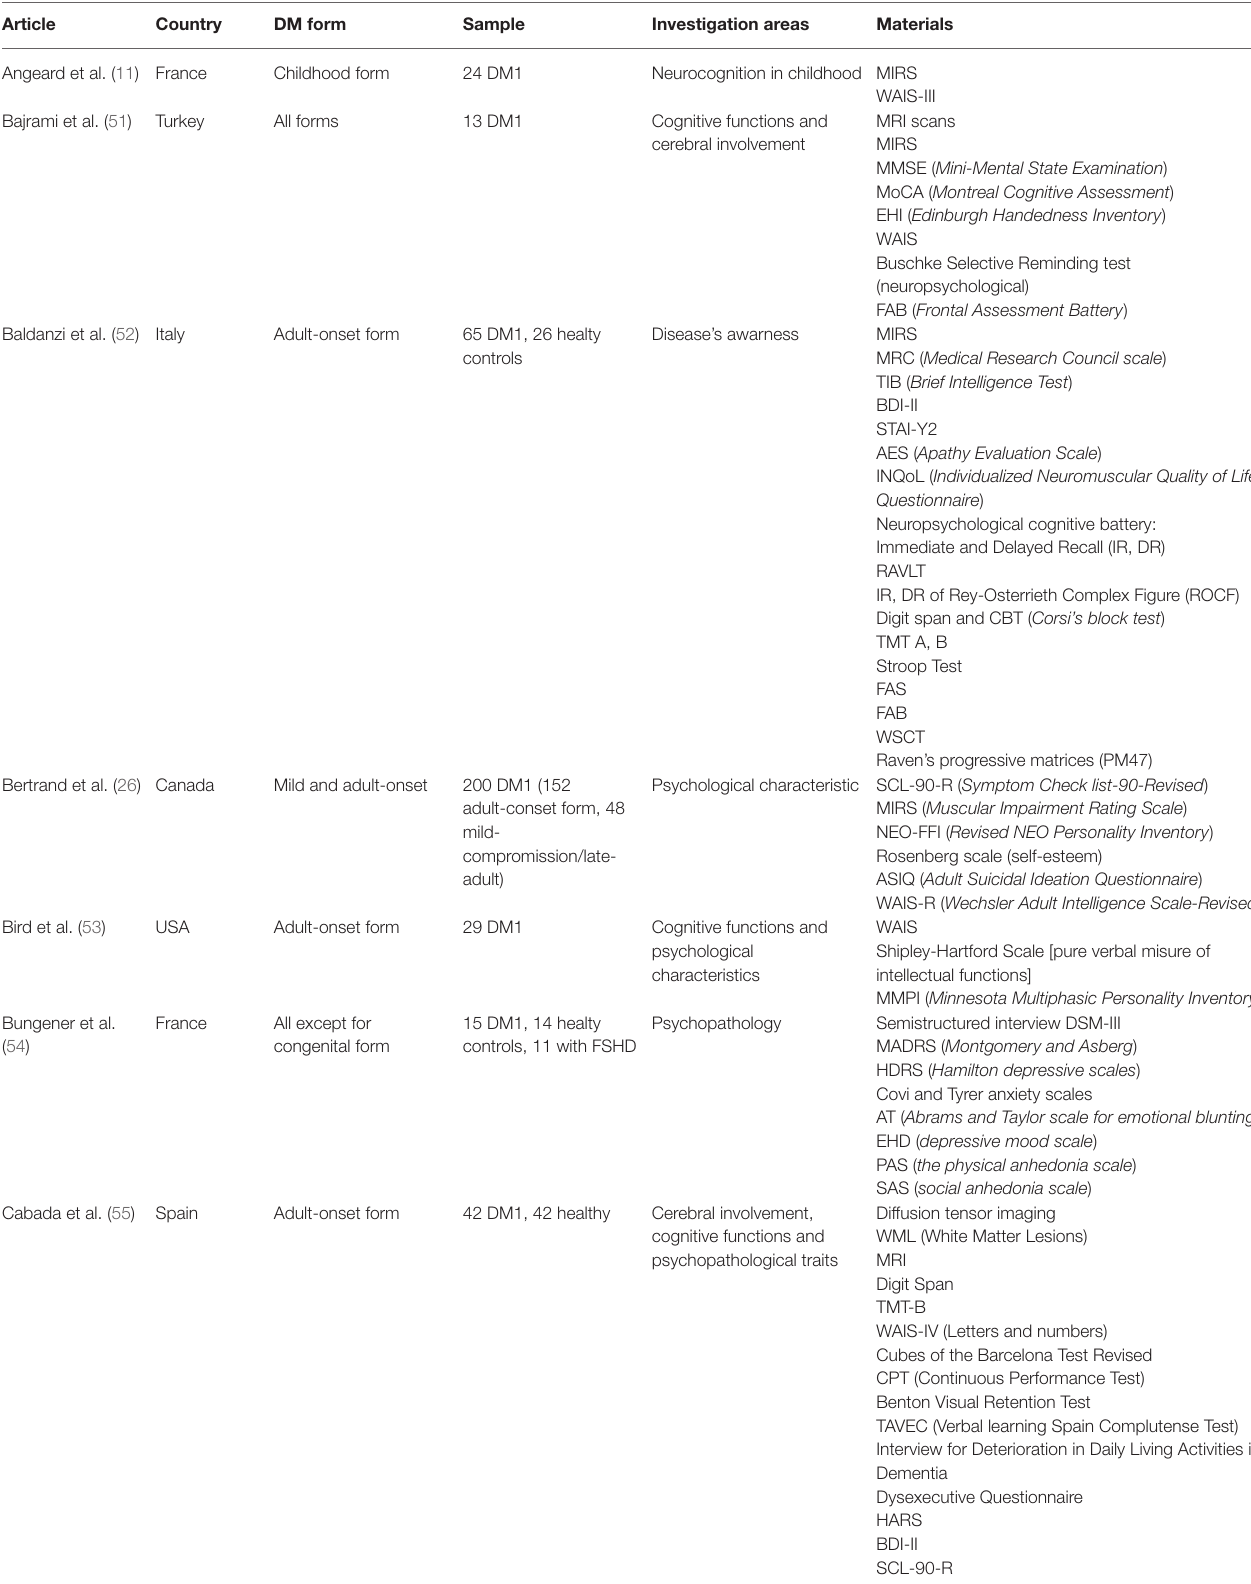
TABLE 1 | Review of neuropsychological and psychological literature on myotonic